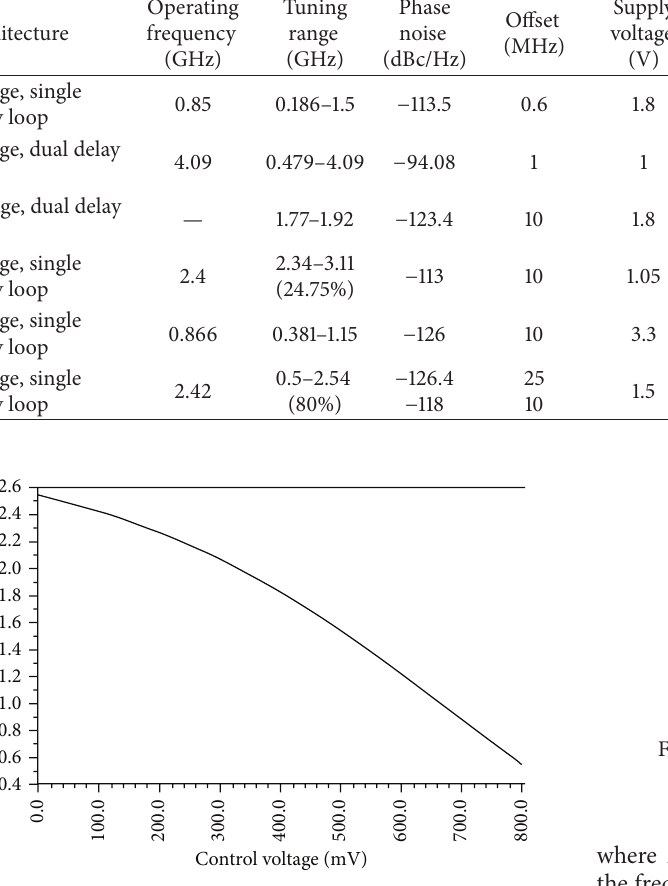
Figure 6: Tuning range of the proposed ring-VCO at 27 ∘ C.